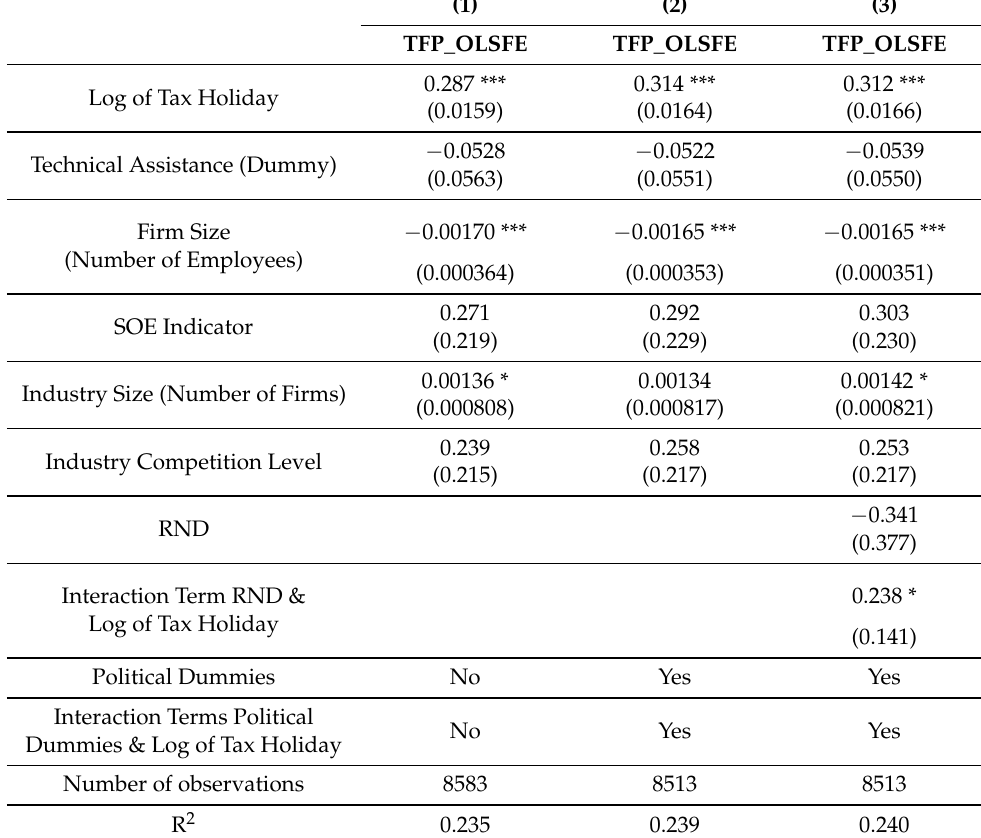
Table A3. Robustness Checks with TFP Measured Using OLS FE method (TFP_OLSFE).